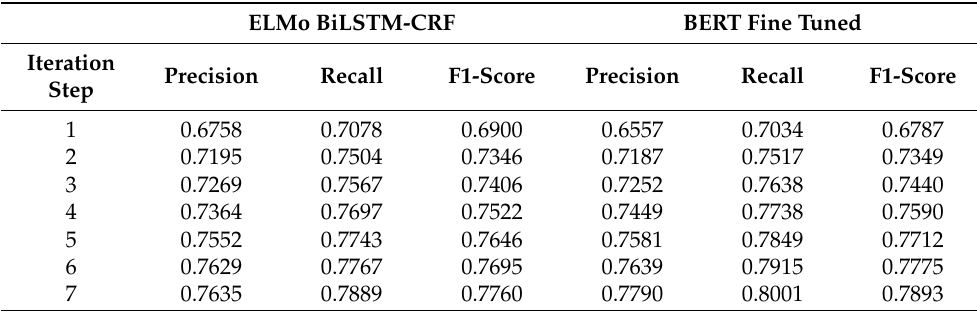
Table 6. Performance of the best performing DNNs (ELMo Bi-LSTM CRF and BERT fine tuned) at each step of the AL phase of the annotation procedure, in terms of precision, recall and F1-Score averaged over all